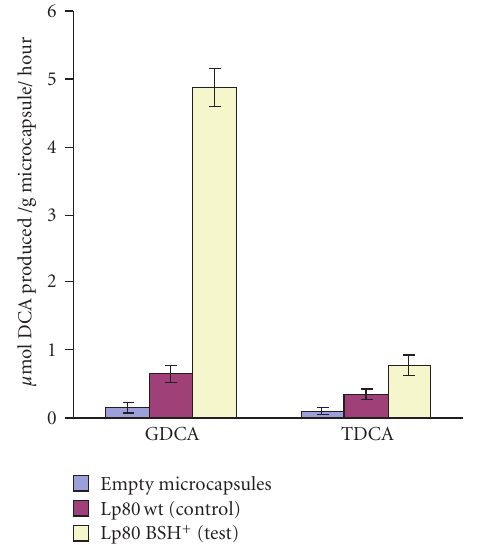
Figure 3: Average BSH activity towards GDCA and TDCA sub- strates in simulated intestine containing empty microcapsules, mi- croencapsulated L. plantarum 80 wild type (control) cells, or mi- croencapsulated L. plantarum 80 BSH + (test) cells.